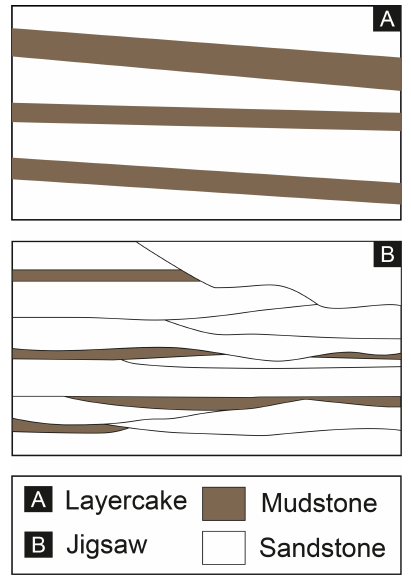
Figure 2. Architectural styles present in the Sherwood Sandstone Group, after Lawrence et al.